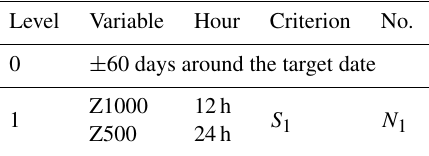
Table 1. Parameters for the reference method on the atmospheric circulation (2Z). The first column shows the level of analogy (0 for preselection). The following columns show the meteorological vari- able and its hour of observation, the criterion used for the current level of analogy, and the number of analogues.